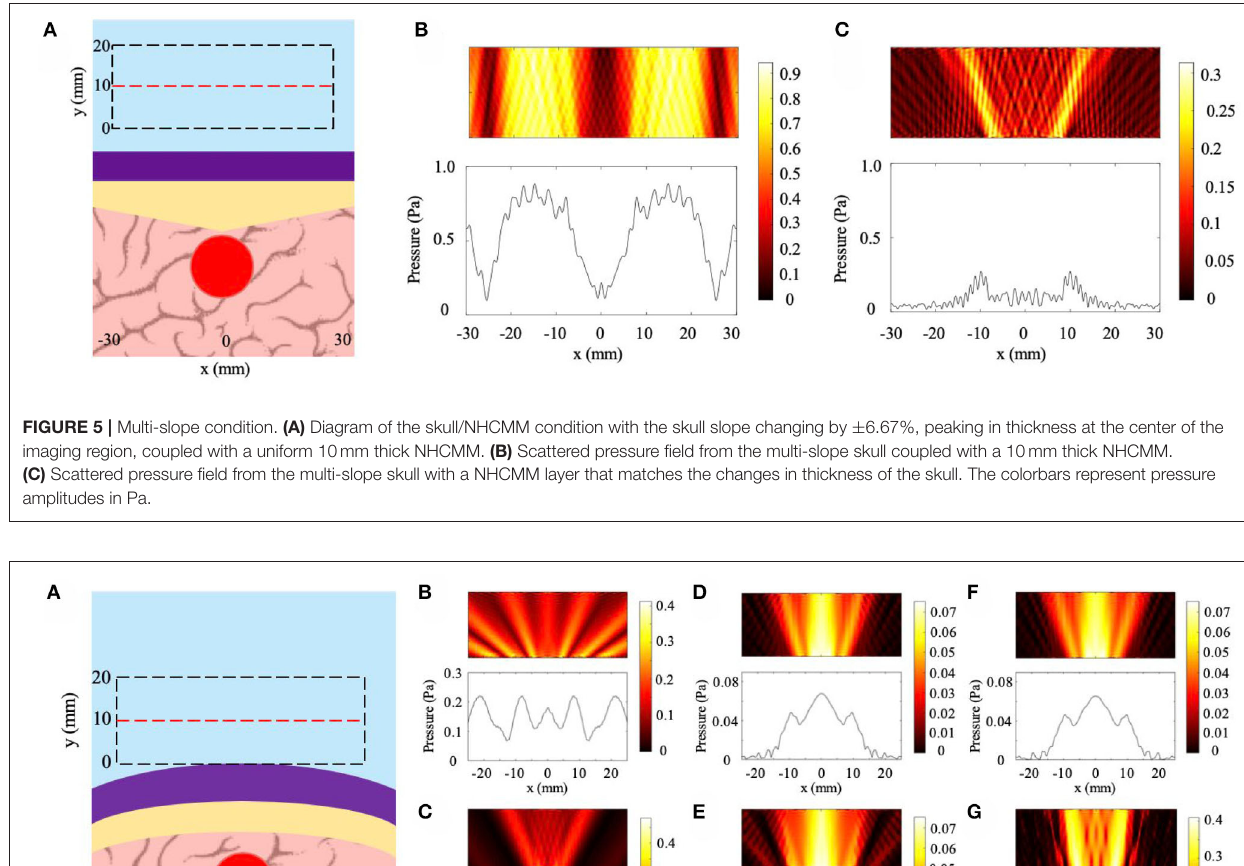
FIGURE 6 | Effects of skull curvature on ultrasound imaging with NHCMM. (A) Illustration of the curved NHCMM-skull setup with a plane wave incident from the top of the subfigure. Reflected pressure fields are taken in the black dashed rectangles with the pressure amplitude recorded on the red dashed line. (B) Backscattered pressure field and pressure amplitude from a tumor without either NHCMM or skull layers. (C) Backscattered pressure field amplitude resulted from imaging through a flat NHCMM-skull bilayer. (D) Filtered pressure field amplitude resulted from imaging through a curved, concentric NHCMM-skull bilayer with an outer skull radius of 100mm. (E) Filtered pressure field amplitude resulted from imaging through a curved, concentric NHCMM-skull bilayer with an outer skull radius of 50mm. (F) Filtered pressure field amplitude resulted from imaging through a curved NHCMM-skull bilayer modeled by shifted circular arcs having radii of 100mm. (G) Filtered pressure field amplitude resulted from imaging through a curved NHCMM-skull bilayer modeled by shifted circular arcs having radii of 50mm. The colorbars represent pressure amplitudes in Pa.